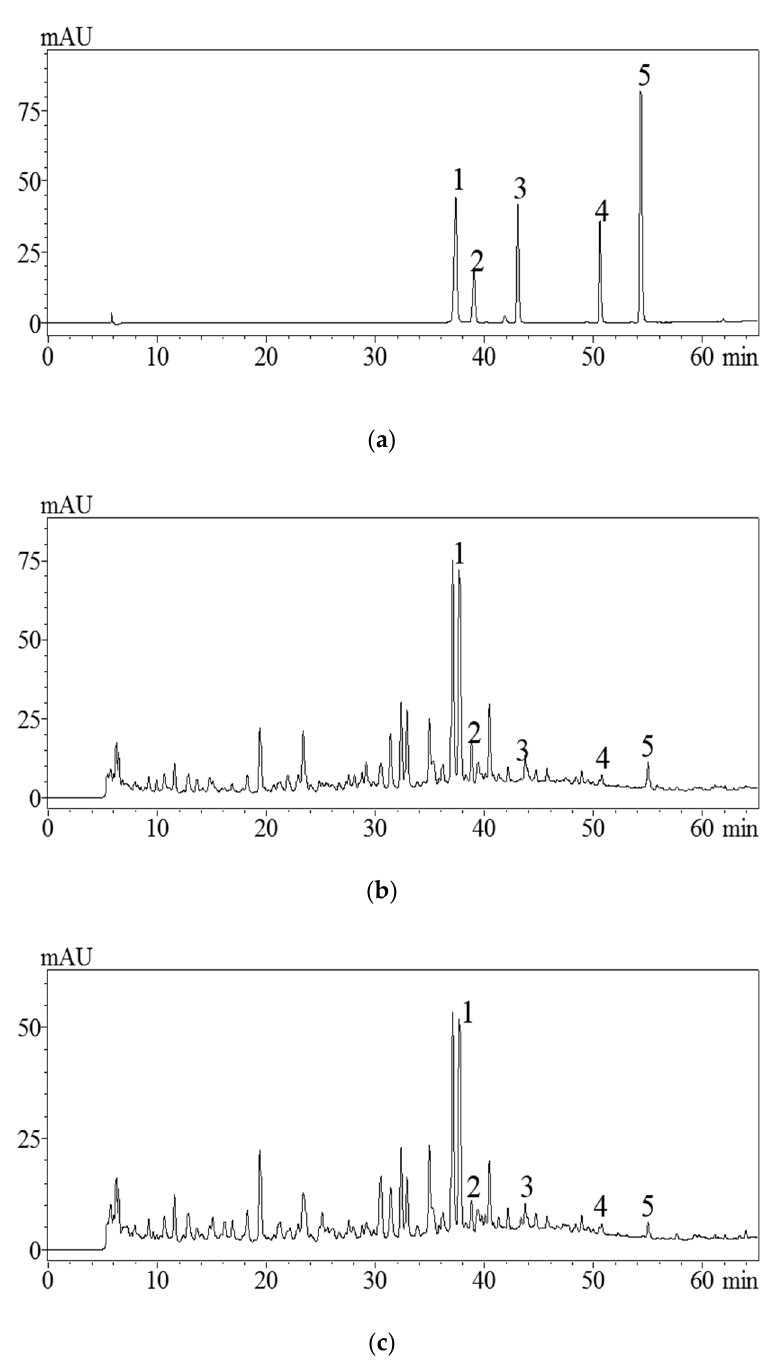
Figure 3. HPLC profiles of standards mixture ( a ) and P. cretica extract obtained by optimized ultrasonic-assisted extraction (UAE) ( b ). P. cretica extract obtained by heat reflux extraction (HRE) ( c ). Peaks (1): Luteolin-7- O -glucoside, (2) rutin, (3) quercitrin, (4) luteolin, and (5) apigenin.